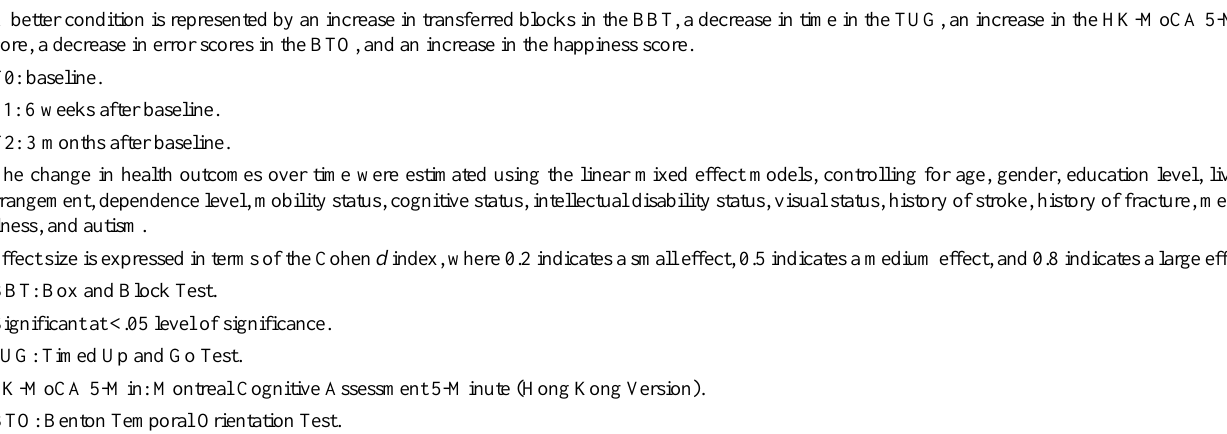
T2 d vs T0T1 b vs T0 c Outcome measures